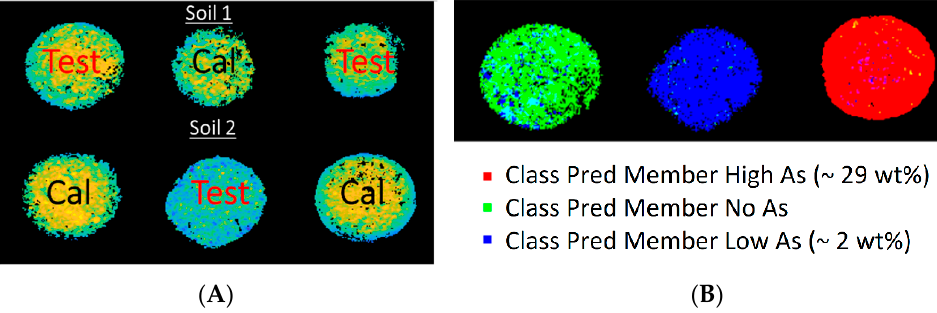
Figure 8. ( A ) Scheme of the samples used for calibration (Cal) and for validation (Test). ( B ) Result of the PLS-DA classification model obtained from the validation set. Table 3. Statistics of PLS-DA for each class, in calibration, cross validation and prediction.